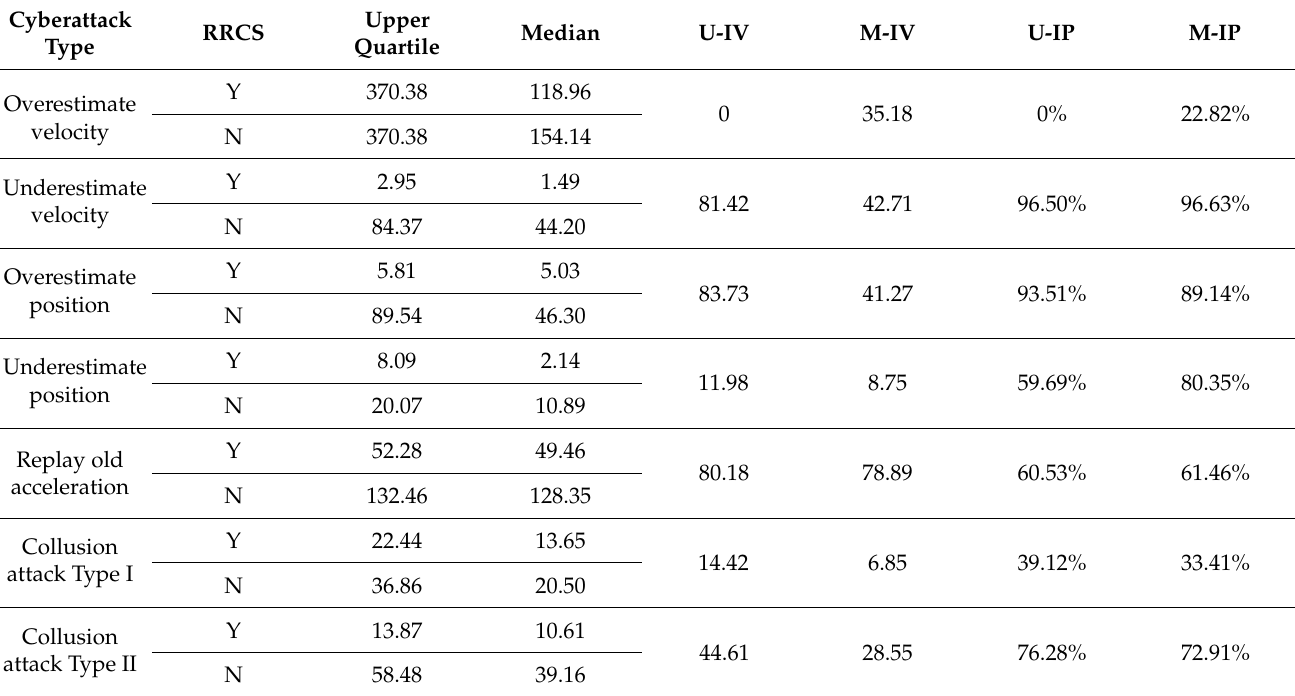
Table 6. Box plot data of variance distribution of headway deviation with or without RRCS under different cyberattack